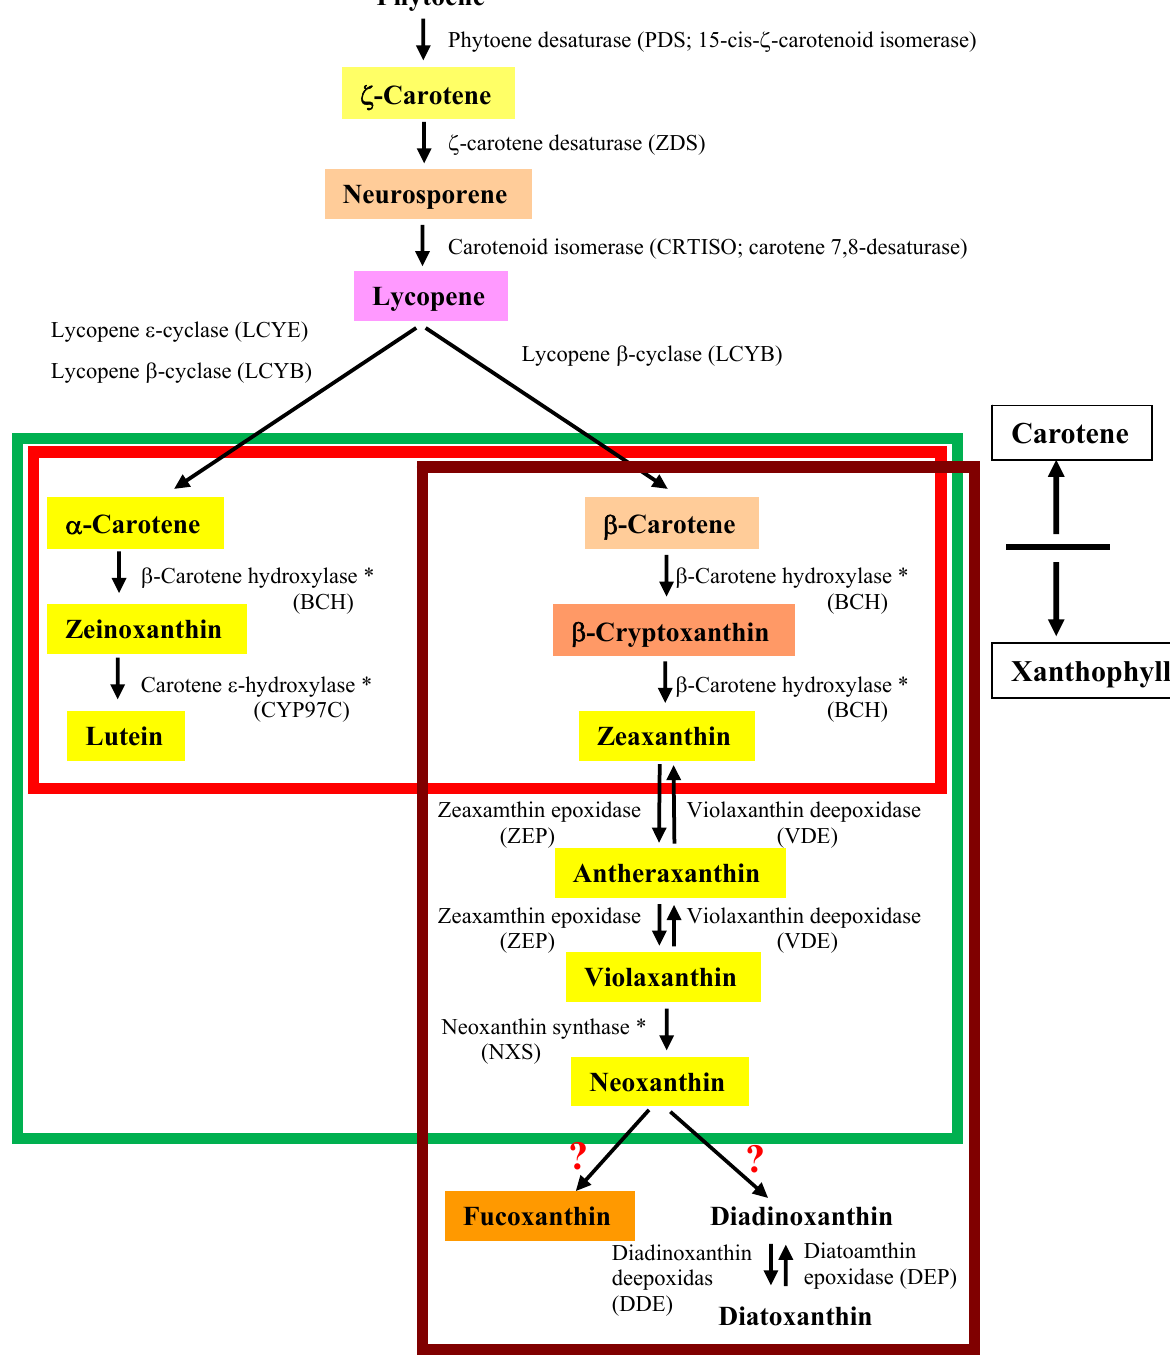
Figure 3. Predicted carotenoid biosynthetic pathway in seaweeds. Red, green and brown boxes reveal the pathway in red, green and brown seaweeds, respectively. The pathways for biosynthesis of zeaxanthin and lutein in red seaweeds and neoxanthin in green seaweeds are proposed based on genomic sequences from Cyanidioschyzon merolae and Chlamydomonas reinhardtii . The color overlapping the name of each carotenoid corresponds to its visible color. The symbol * indicates enzymes unidentified in